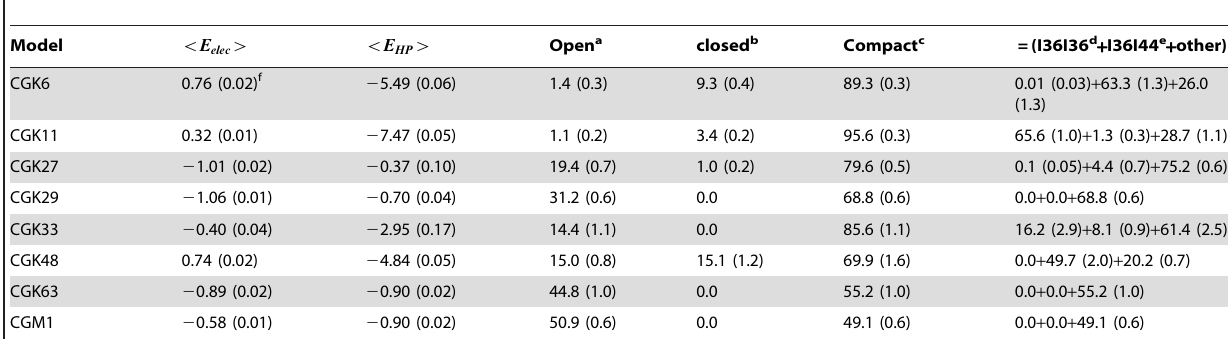
a Open state is defined as the conformations with R COM w 3 : 2 nm . b Closed state is defined as the conformations with R I 44 I 44 v 0 : 86 nm . c The remaining conformational space with the exception of open and closed states is defined as compact state. The compact state can be further divided into I36-I36, I36–I44 and other compact state according to the role of I36 and I44 hydrophobic patches in the formation of interface between Ub